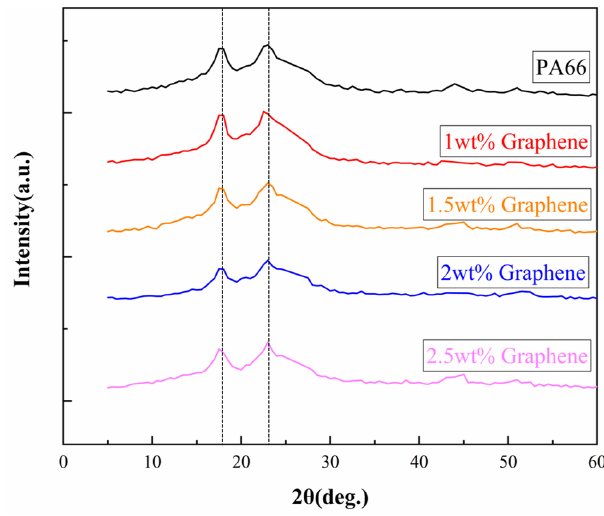
Figure 3. XRD patterns of PA66/graphene with different graphene mass fractions.